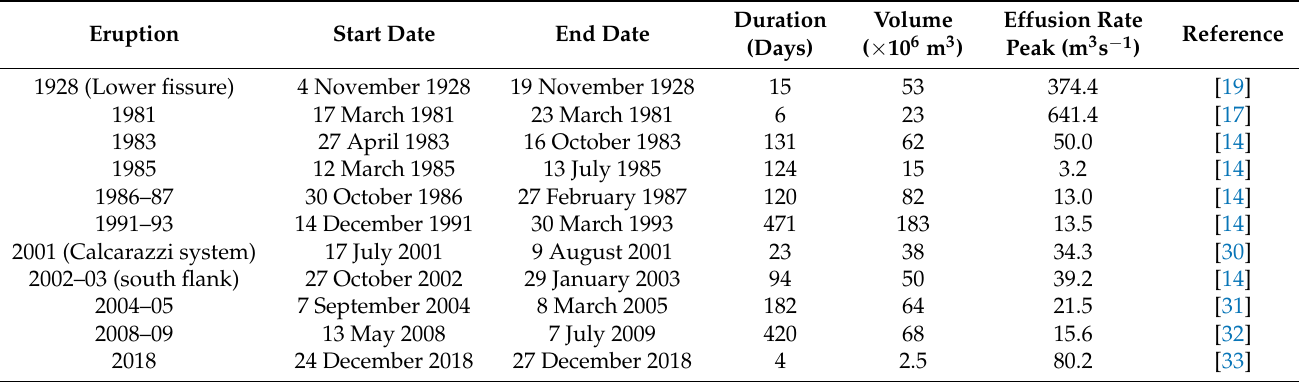
Table 1. Start and end date, duration, volume, effusion rate peak and reference for the investigated flank eruptions at Mt.